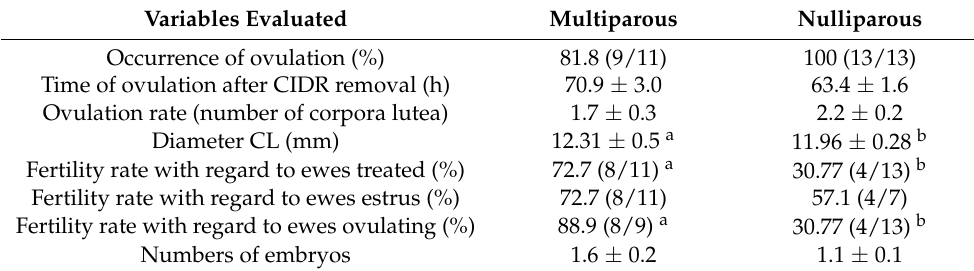
Different letters indicate significant differences between groups (a (cid:54) = b: p <